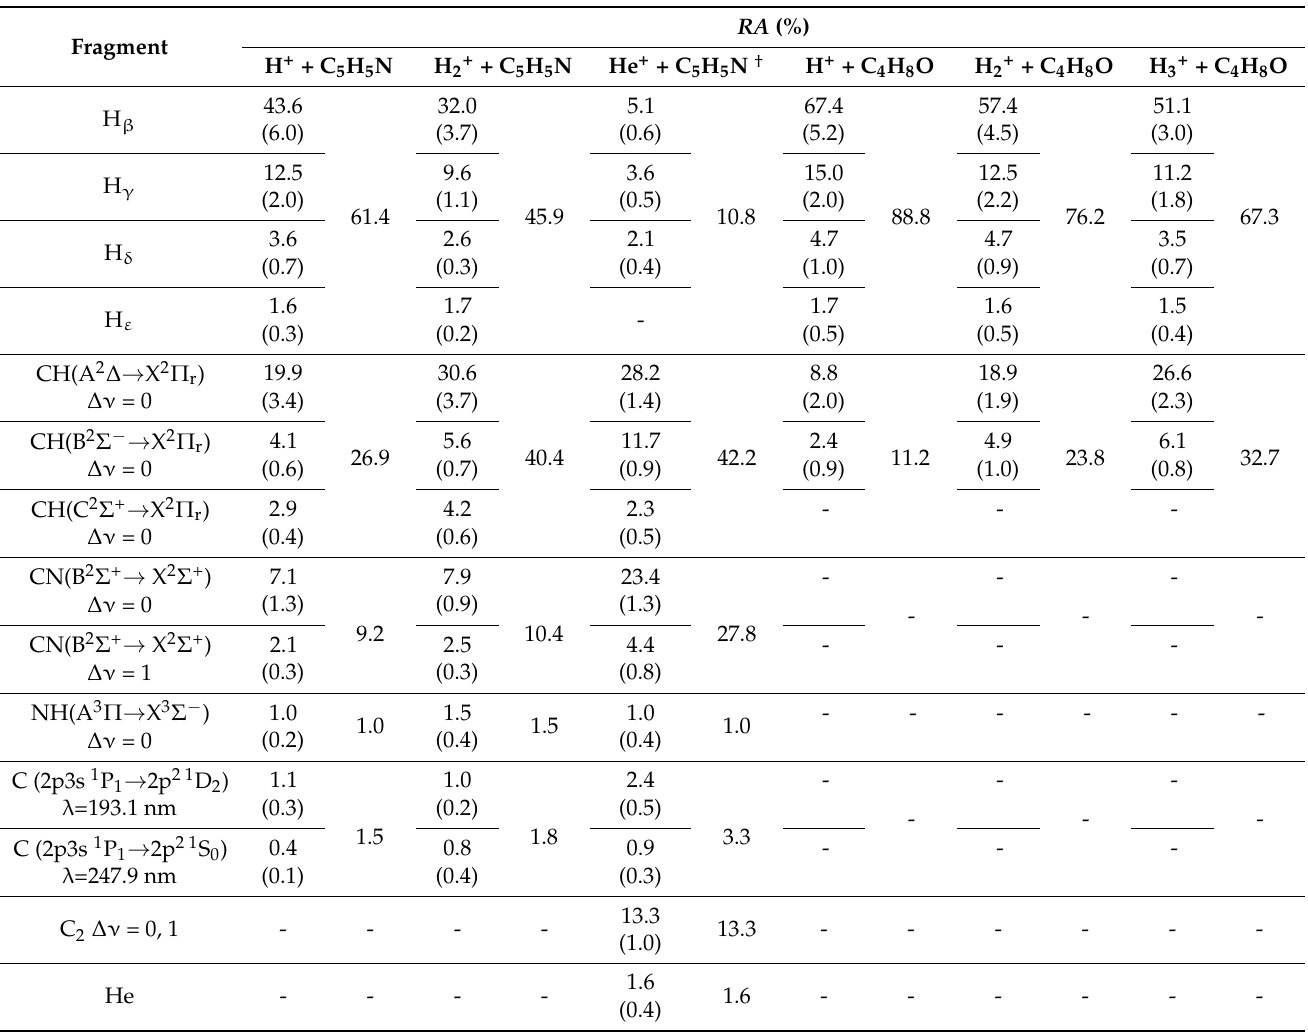
Table 2. The average relative abundances ( RA ) of excited fragments. The results of He + + C 5 H 5 N were taken from [32], while the results for H + , H 2+ , and H 3+ collisions with tetrahydrofuran were adopted from [24–26], respectively. The NH(A 3 Π ) data from [27] were also used. The numbers in brackets represent the calculated